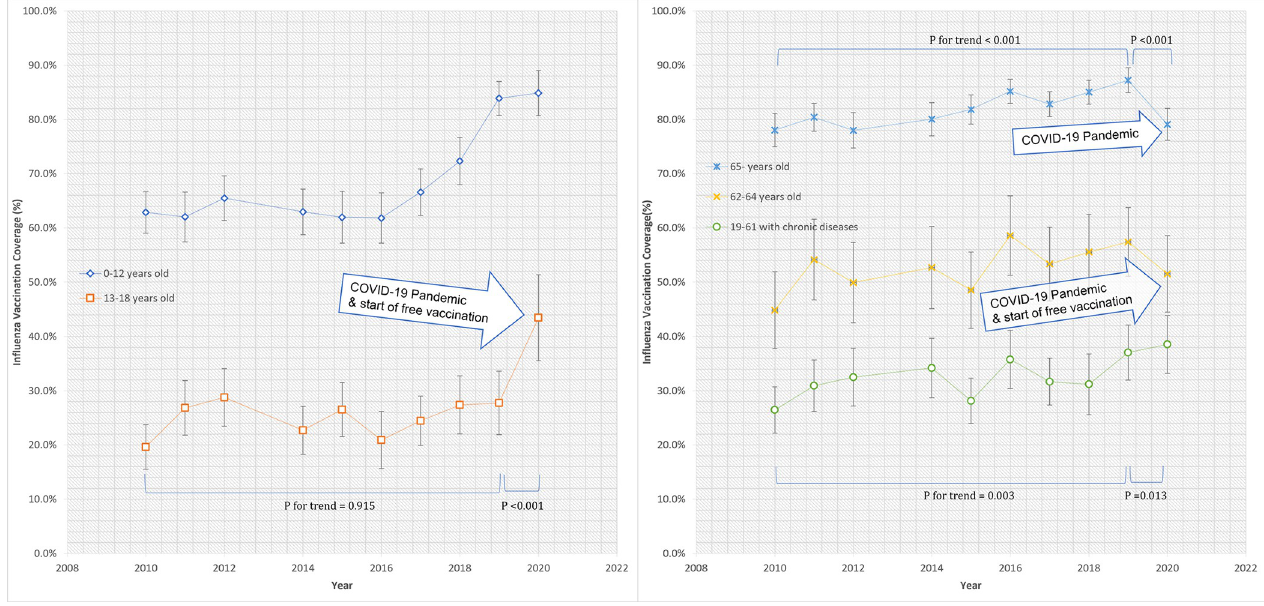
Fig 1. Trends of influenza vaccination coverages in target groups during